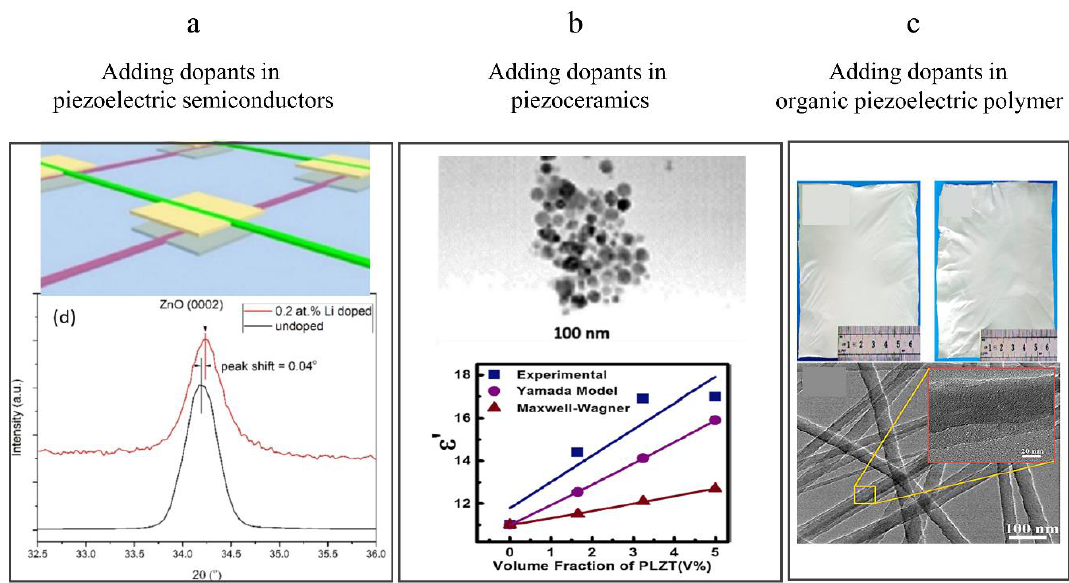
Figure 6. Addition of dopants. ( a )Adding dopants in ZnO: structural schematic diagram (upper part) and XRD spectrum (lower part). Copyright from Elsevier. ( b ) Adding dopants in PZT: SEM image (upper part) and dielectric constants (lower part). Copyright from Springer Nature. ( c ) Adding dopants in PVDF: structural schematic diagram (upper part) and SEM image (lower part). Copyright from ACS.